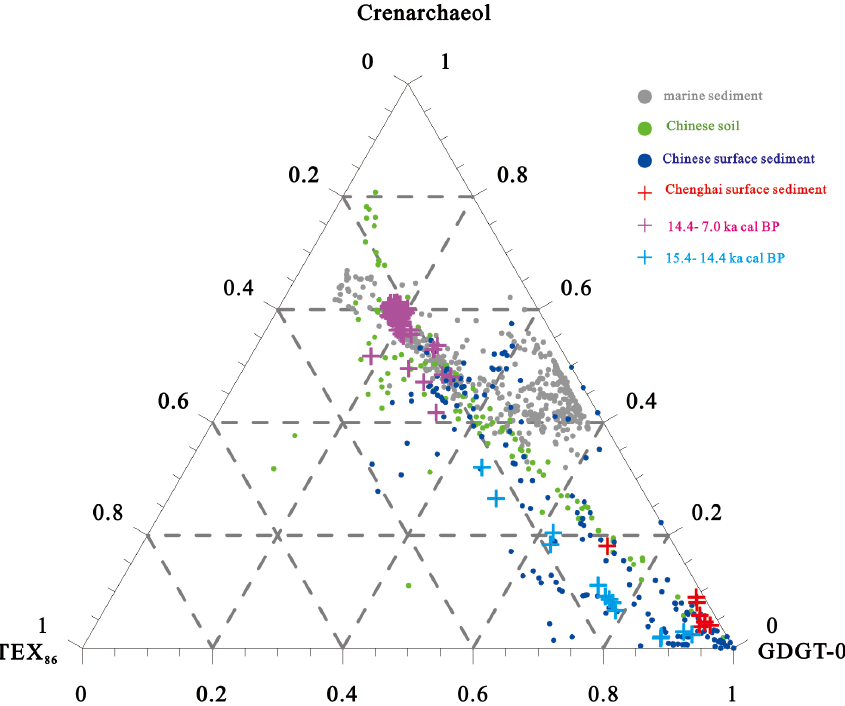
Figure 4. Ternary diagram showing the distributions of GDGT-0, crenarchaeol, “TEX 86 ” GDGTs in surface and core sediments from Lake Chenghai, global marine sediments (Kim et al., 2010), published Chinese soils compiled by Yao et al. (2019), and Chinese lacustrine surface sediments (Günther et al., 2014; Dang et al., 2016; Hu et al., 2016; Li et al., 2016, 2019; Yao et al., 2019; Wang et al.,